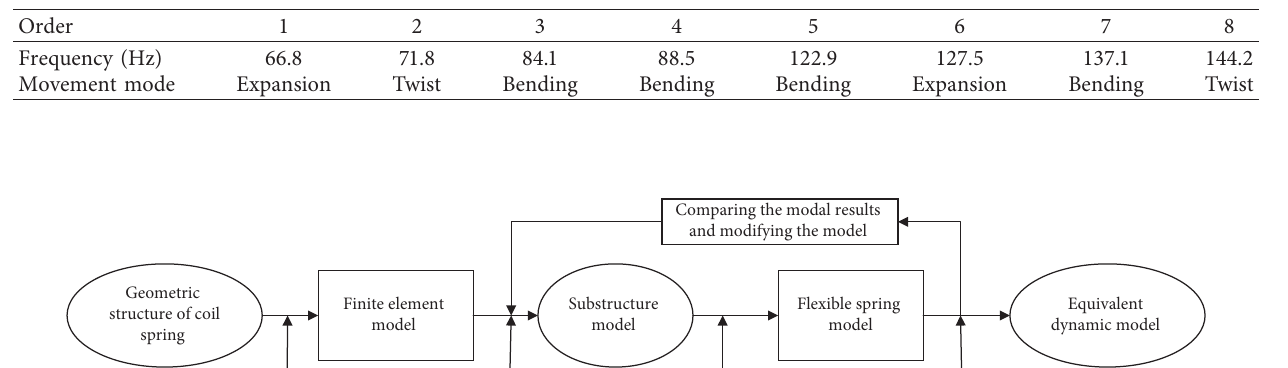
Figure 3: Coil spring model. (a) Helix. (b) Beam element equivalent model. Table 3: The constrained modes of the coil spring.